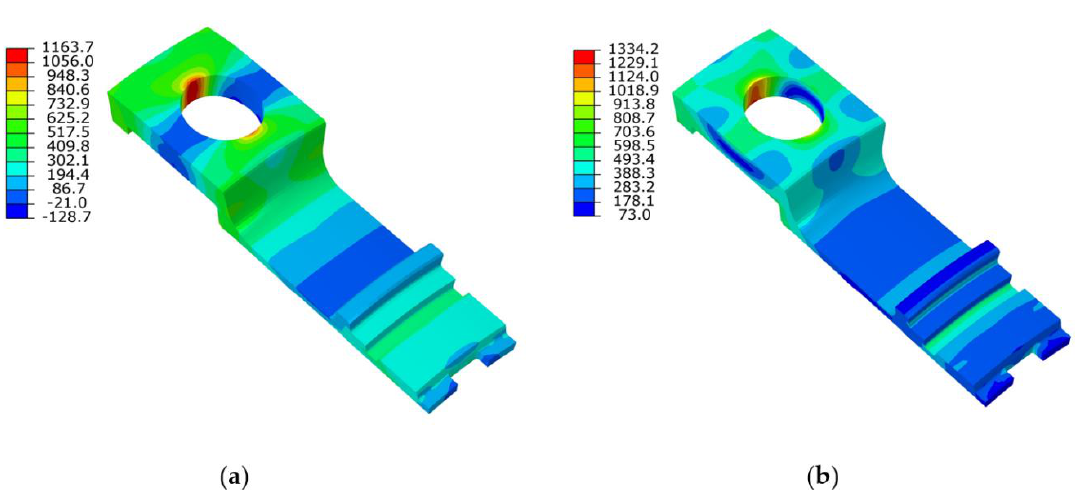
Figure 6. Stress distribution of support ring under working condition (120% relative speed, unit: MPa): (a) Hoop stress; (b) Equivalent stress.